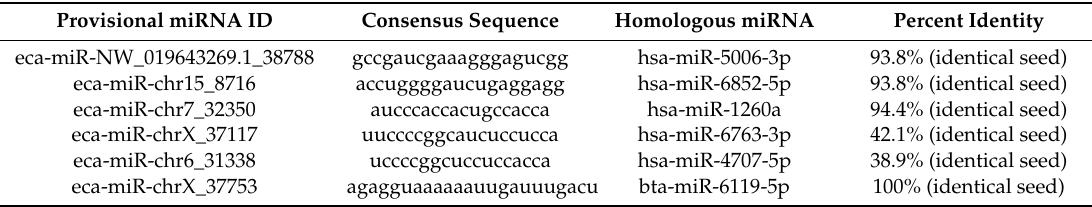
Table 6. Di ff erentially expressed putative novel equine miRNAs in any of the three group comparisons. The miRDeep2 given provisional miRNA ID, the consensus sequence of the novel equine miRNA, as well as a potential human homologous miRNA ID are listed.